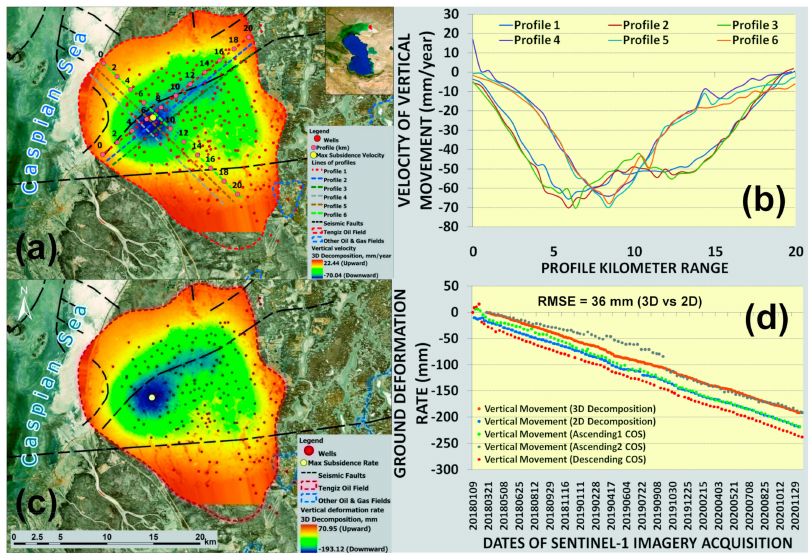
Figure 7. ( a ) Location of maximum subsidence in the area of vertical deformation velocity derived from 3D decomposition; ( b ) Profiles of vertical movement velocity; ( c ) Maximum subsiding location with the background of vertical deformation rate derived from 3D decomposition; ( d ) Vertical deformation rates derived from 3D and 2D decompositions and cosine corrections for the location of maximum